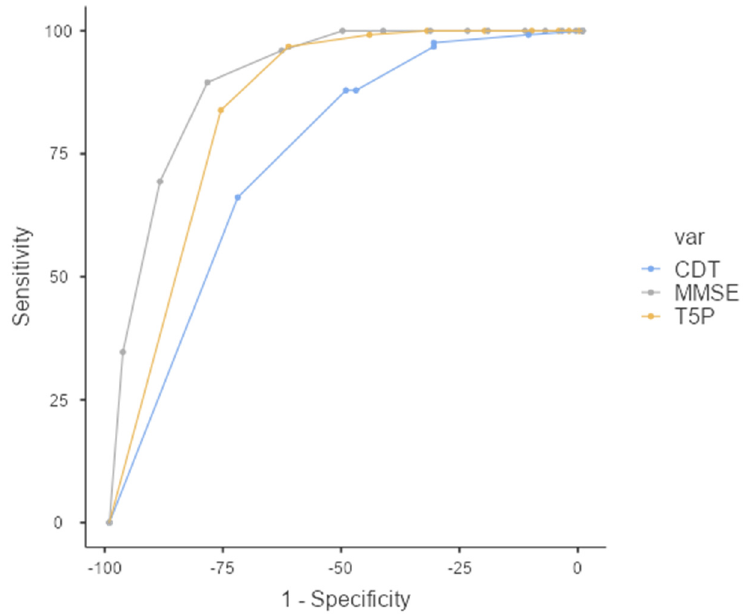
Figure 3. ROC Curve—T5P total score ≤ 9 discriminates between PAT group and HC group. MMSE: Mini-Mental State Examination, CDT: clock drawing test, T5P= Test delle 5 Parole.